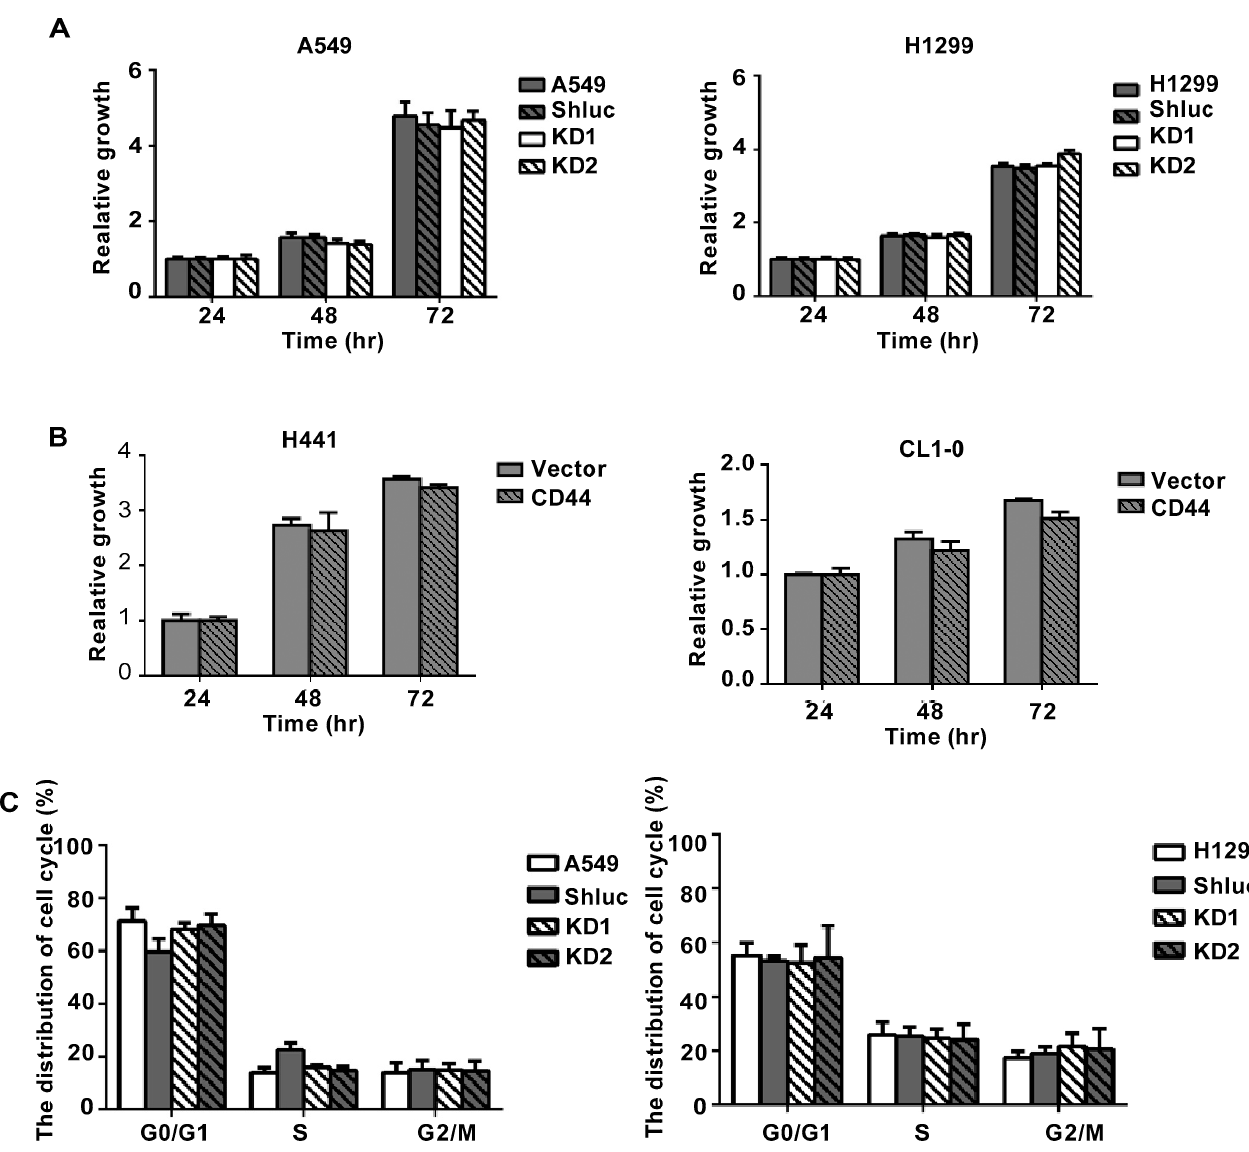
Figure 3. CD44 expression has no significant effects on cell proliferation and cell cycle. ( A ) Cell viability analysis in A549 and H1299 cells with CD44 knockdown. ( B ) Cell viability analysis in H441 and CL1-0 cells with CD44 overexpression. ( C ) Cell cycle analysis in A549 and H1299 cells with CD44 knockdown.